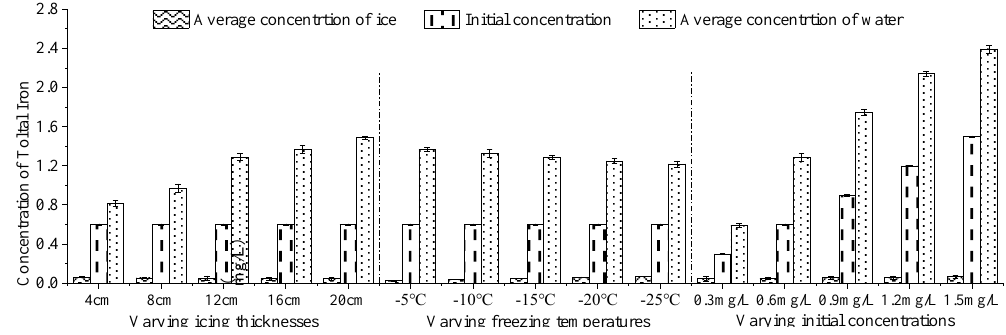
Figure 2. Distribution of iron in ice–water system during water icing. (Error bar: Mean ± S.D., K: the ratio of the average concentration of iron in the ice to that in the under-ice water).